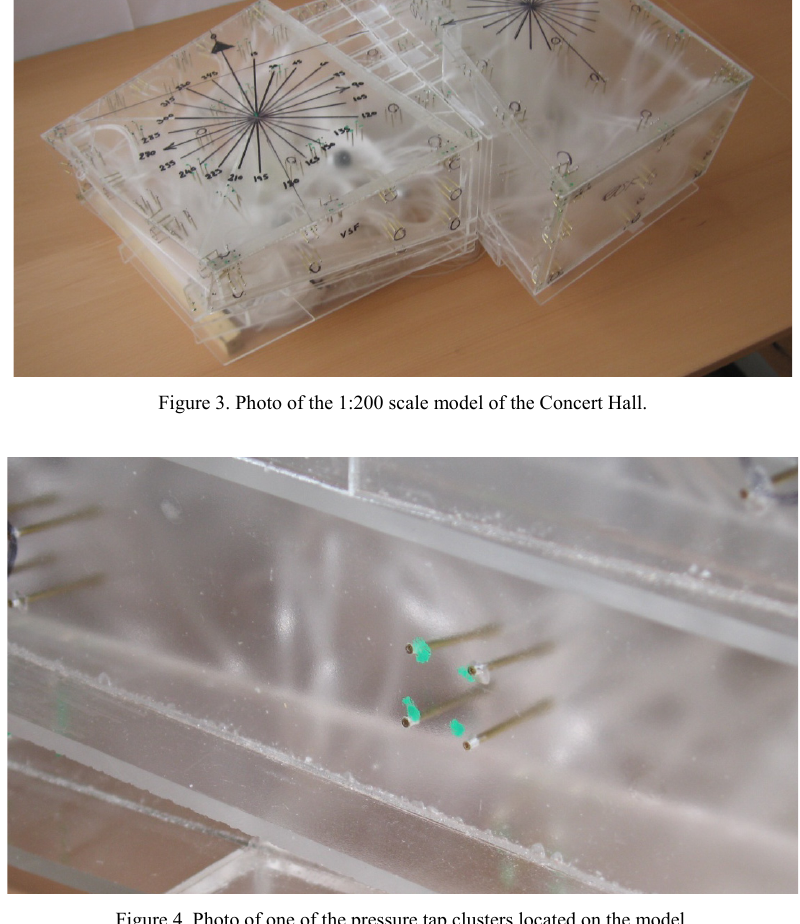
Figure 4. Photo of one of the pressure tap clusters located on the